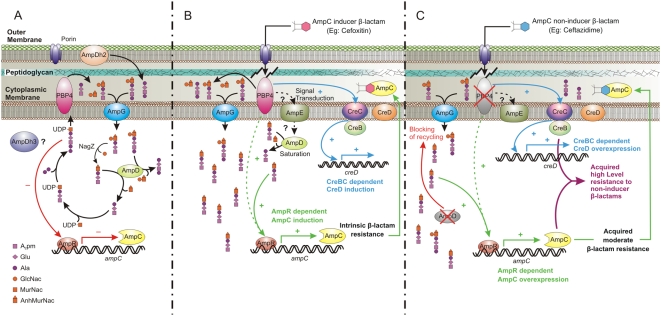
Schematic representation of the regulation of the P. aeruginosa chromosomal β-lactamase AmpC and peptidoglycan recycling under different conditions.(A) Wild-type strain in the absence of β-lactams. During regular bacterial growth, the peptidoglycan degradation products, MurNac-peptides [N-acetylglucosaminyl-1,6-anhydro- N-acetylmuramyl-tri (or tetra) peptides], are generated in the periplasm through the activity of PBP4 and several other enzymes. These products are then internalized through the permease AmpG, and processed in the cytoplasm by the β-N-acetylglucosaminidase NagZ and the N-acetyl-anhydromuramyl-L-alanine amidase AmpD. P. aeruginosa has two additional AmpD proteins, AmpDh2 that it is apparently located in the outer membrane and AmpDh3 that is still of unknown location. The generated tripeptides are then incorporated to the murein biosynthesis pathway to yield the UDP-MurNac-pentapeptides that will be exported to the periplasm and incorporated to the peptidoglycan, to complete the recycling process. In the absence of β-lactam antibiotics, these UDP-MurNac-pentapeptides interact with AmpR, which functions as a negative regulator of ampC expression. (B) Growth of wild-type strain in the presence AmpC inducer β-lactams. During growth in the presence of certain β-lactams (AmpC inducers), such as cefoxitin or imipenem, AmpC is produced at high levels, conferring natural (intrinsic) resistance to the antibiotic, provided it is a good substrate for the enzyme (as occurs for cefoxitin but not for imipenem). The exact mechanism responsible for the induction of the expression of AmpC in the presence of these antibiotics is still not fully understood. One of the components of the induction process is apparently the saturation of AmpD, due to the enhanced generation of its substrate (MurNac-tripeptides). The accumulated MurNAc-tripeptides are thought to displace the UDP-MurNAc-pentapeptides from AmpR, converting it into an activator of ampC transcription. Our results, and other previous indirect evidences, suggest that the inhibition of PBP4 by these β-lactam antibiotics (known to be the most potent PBP4 inhibitors) plays a major role in the ampC induction process, and determines the activation of the CreBC (BlrAB) two-component regulator. The exact function of the signal transducer AmpE, located in the inner membrane, still needs to be elucidated, but apparently interacts with both AmpD and PBP4. (C) Growth of the AmpD and/or PBP4 mutants in the presence of AmpC non-inducer β-lactams (most antipseudomonal cephalosporins and penicillins, such as ceftazidime or piperacillin, respectively). The inactivation of PBP4 or AmpD produces a very similar constitutive ampC overexpression. Both mechanisms ultimately relay in the activation of AmpR, which changes its activity from negative to positive regulator of ampC expression. Independently of the mechanism, AmpC overexpression itself is shown to confer only moderate (low-level) acquired resistance to non-inducer β-lactams. Additionally, the inactivation of PBP4 specifically activates the CreBC (BlrAB) system, which drives, in conjunction with the AmpC overexpression, the high-level β-lactam resistance response.